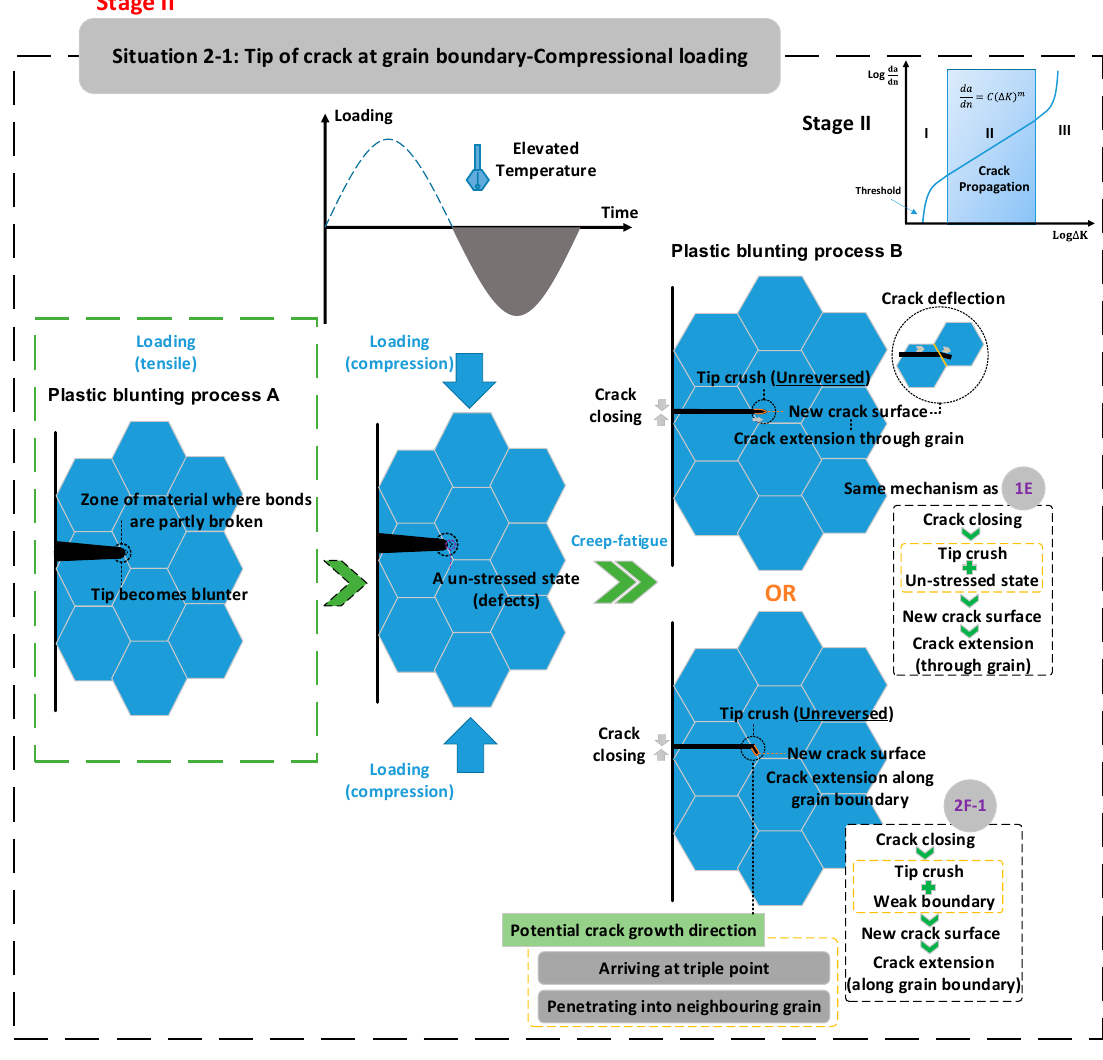
Figure 12. Crack tip at grain boundary—Compressional loading.